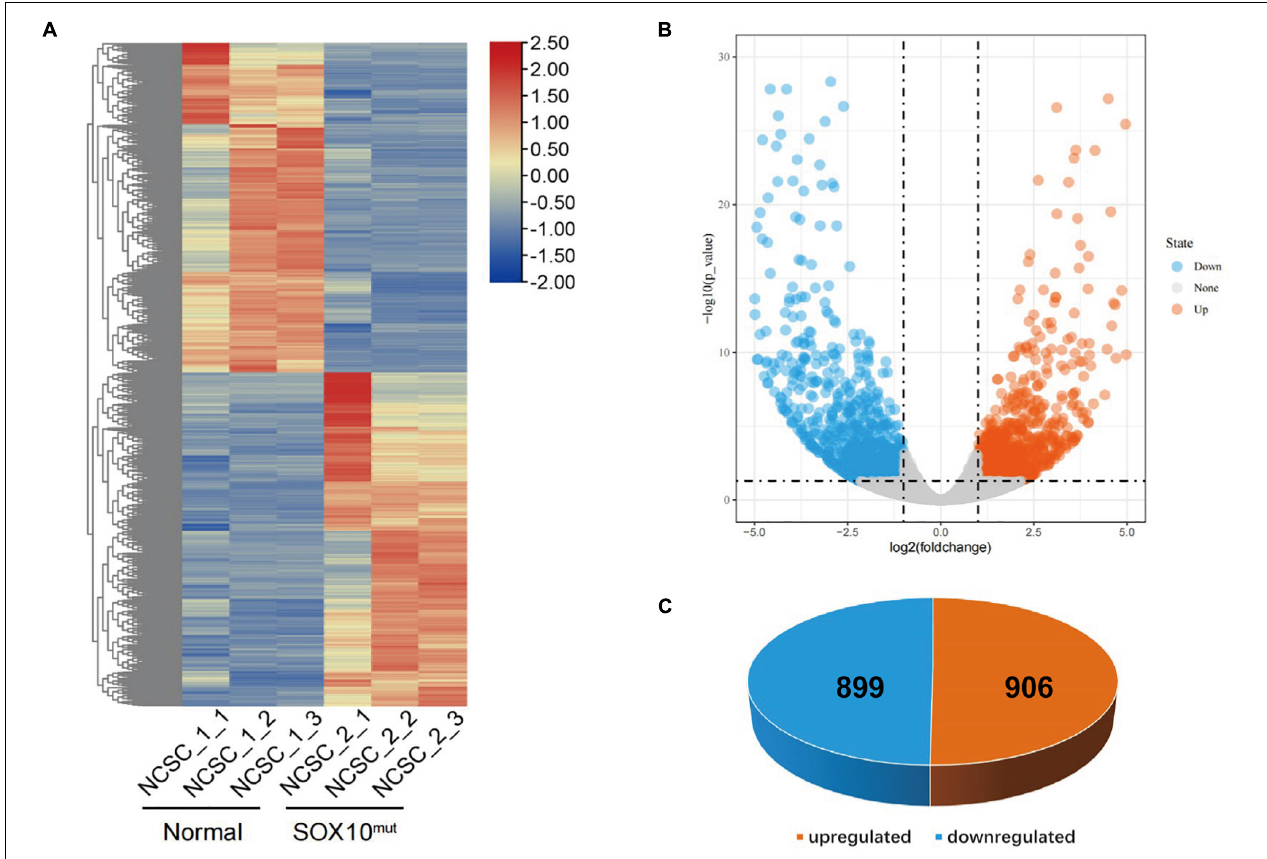
FIGURE 7 | Differentially expressed genes in SOX10 mutant iNCCs. (A) The heatmap showed hierarchical clustering analysis of DEGs in SOX10 mutant iNCCs. The FPKM values of DEGs were normalized by scale function and compared between the SOX10 mutant iNCCs and normal control. Red and blue indicate genes with high and low expression levels, respectively. (B) Volcano plot showing the expression change of each gene and their significance. Red dots represent the expression of genes in SOX10 mutant iNCCs significantly upregulated compared to normal control. Blue dots represent the expression of genes in SOX10 mutant iNCCs significantly downregulated compared to normal control. (C) A total of 906 genes were up-regulated and 899 genes were down-regulated among the